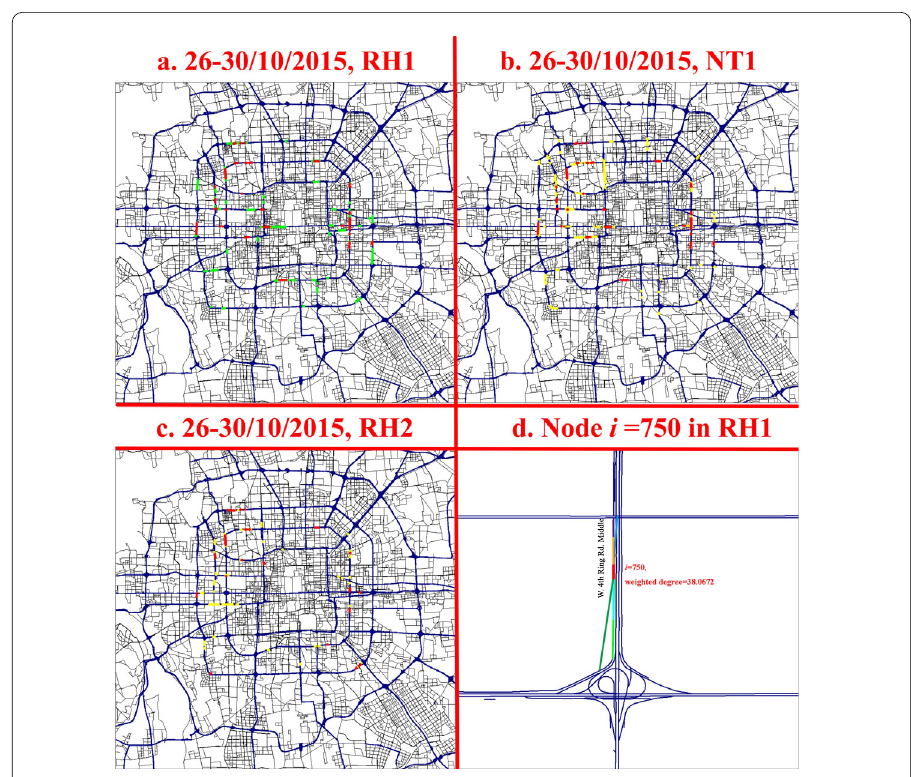
Figure 6 Road sections with the 20% largest weighted degrees on Beijing map. ( a ), ( b ) RH1 and NT1. 223 nodes in RH1 (green segments) and 227 nodes in NT1 (yellow segments), with 90 overlapping nodes (red segments). The percentages of the overlapping nodes among the selected hub nodes in RH1 and NT1 are 40.4% and 39.7%, respectively. ( c ) RH2. 116 nodes in RH2 (yellow segments), with 56 overlapping nodes with RH1 (red segments). The percentage of the overlapping nodes among the 116 selected hub nodes is 48.3%. ( d ) Demonstration of node i = 750, with a large weighted degree (38.1) in RH1. The node is shown as a red segment, and its 6 links (in different colors) with other nodes. The data is during 26–30 Oct. 2015, N = 4530, L = 900, and τ max =